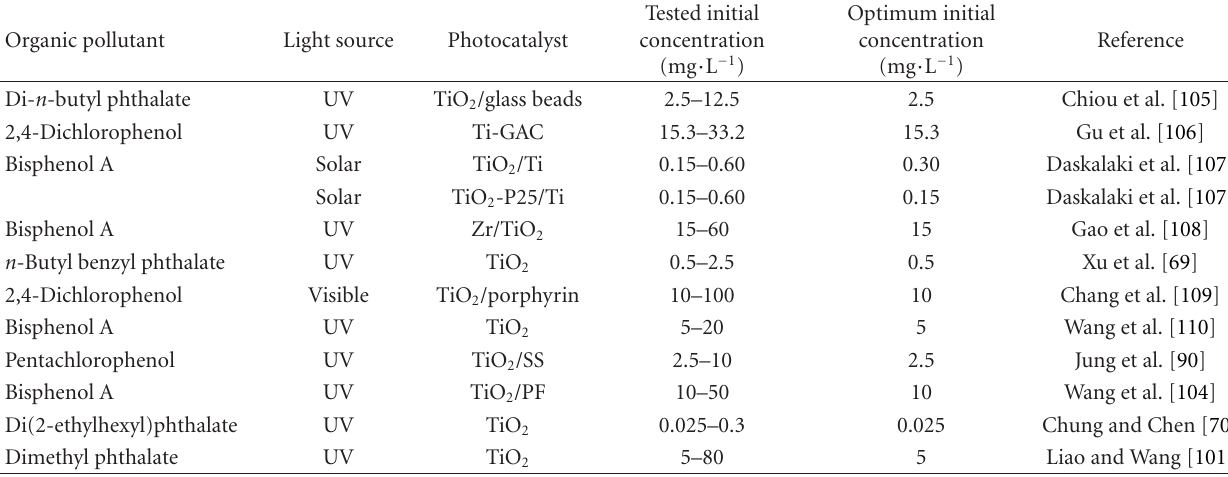
Table 1: E ff ect of initial substrate concentration on the photocatalytic degradation of various EDCs.